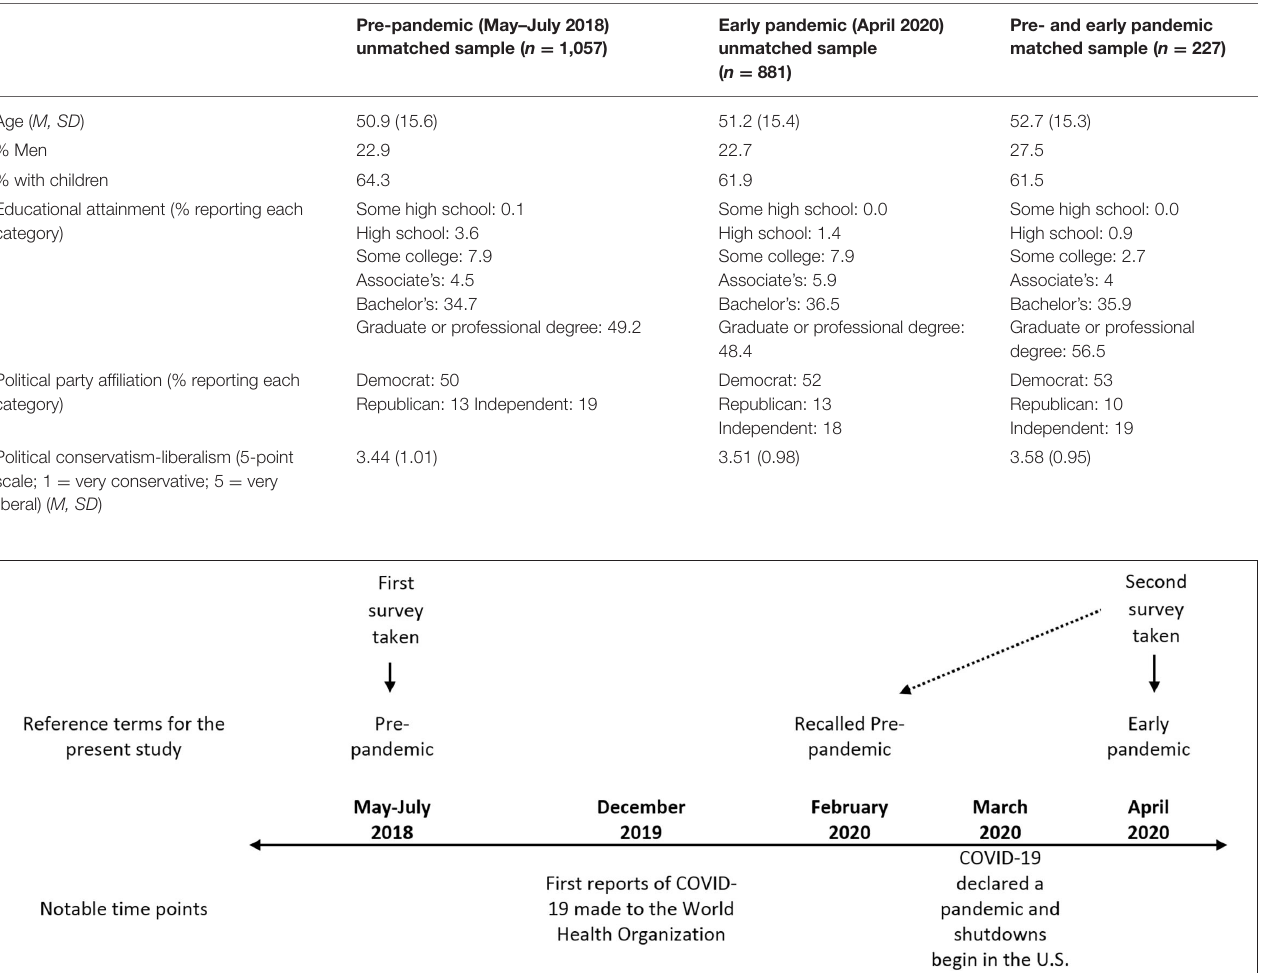
TABLE 1 | Sample characteristics.